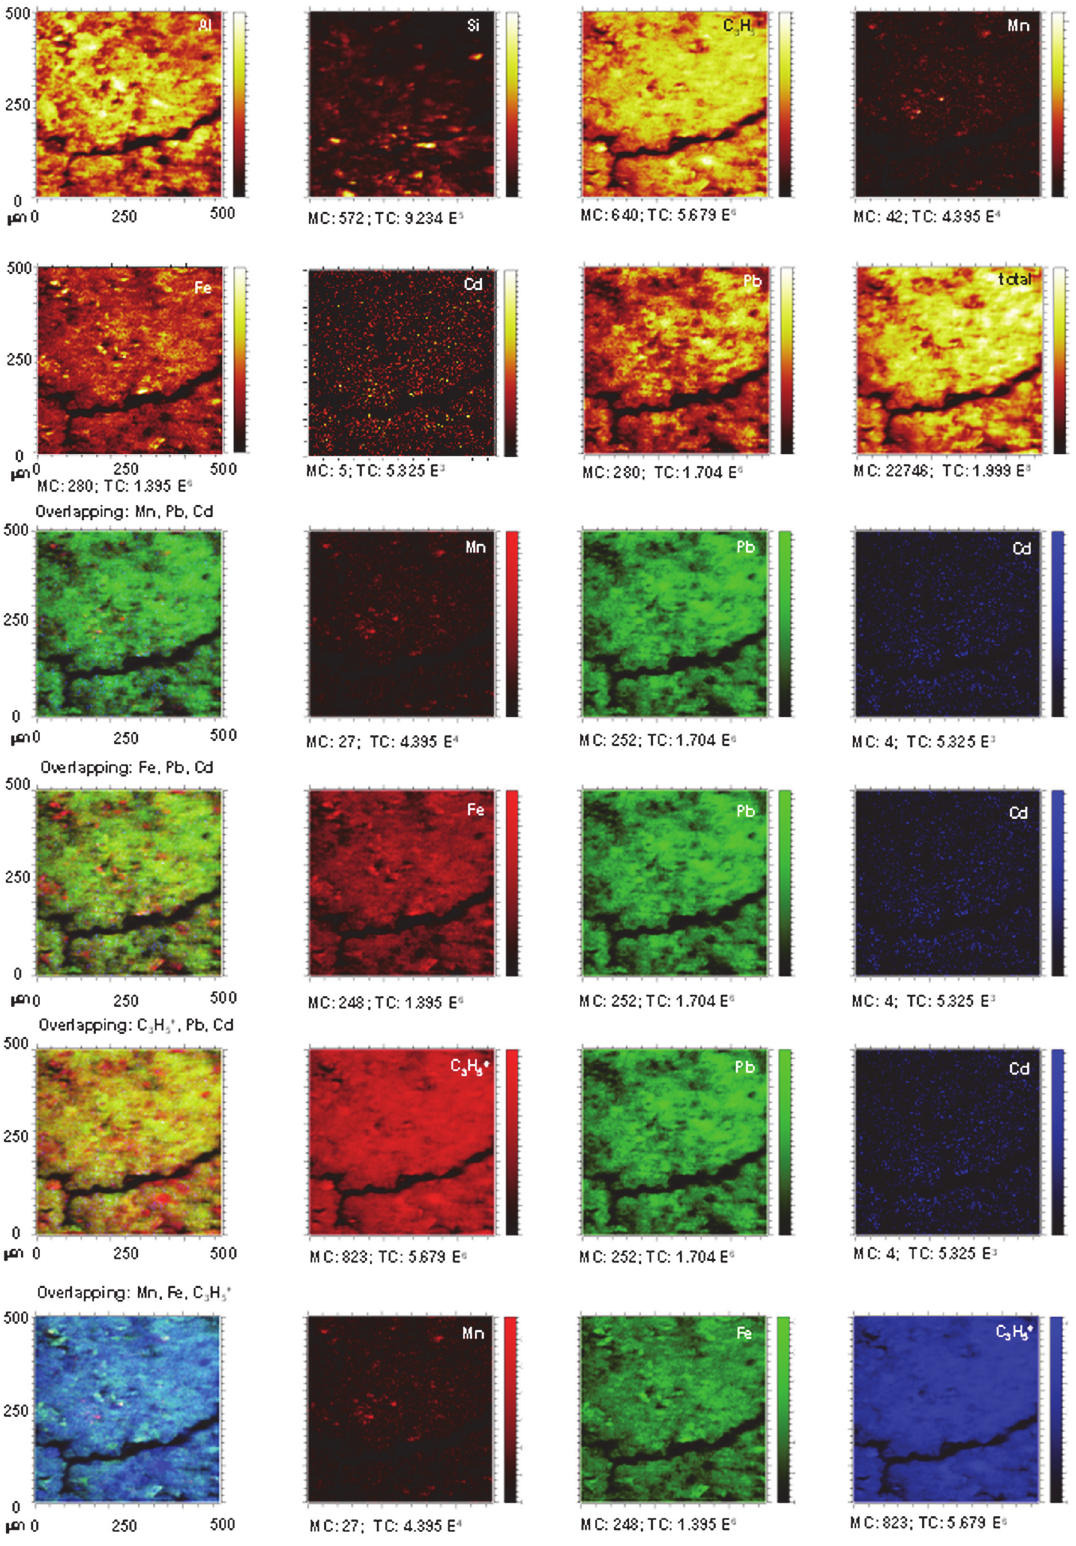
Fig 4. DU.Bw treated with Pb 2+ and Cd 2+ . TOF-SIMS images of Al, C 3 H 5+ , Si, Fe and Mn ions, and overlapping all the signals with Pb 2+ and Cd 2+ . Images of overlapping: Mn + Pb + Cd; Fe + Pb + Cd; C 3 H 5+ + Pb + Cd; and Mn + Fe + C 3 H 5+ showing the concordance between signals. doi:10.1371/journal.pone.0123977.g004 PLOS ONE | DOI:10.1371/journal.pone.0123977 April 20,